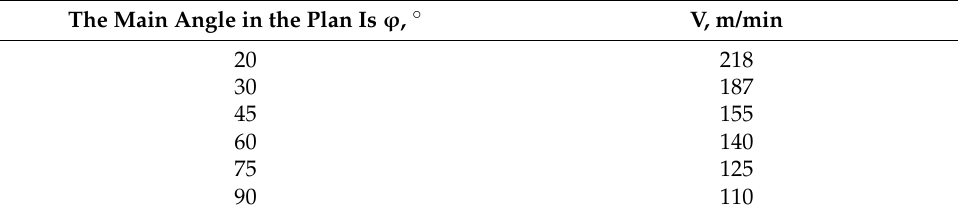
Table 4. Influence of the angle ϕ on the possible cutting speed V .